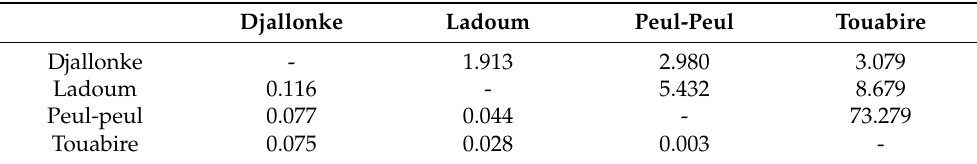
Table 3. Pairwise genetic differentiation (Fst, lower triangular matrix) and gene flow (Nm, upper triangular matrix) among the Senegalese sheep breeds based on the polymorphisms of 44,321 SNPs. Djallonke Ladoum Peul-Peul Touabire Djallonke -